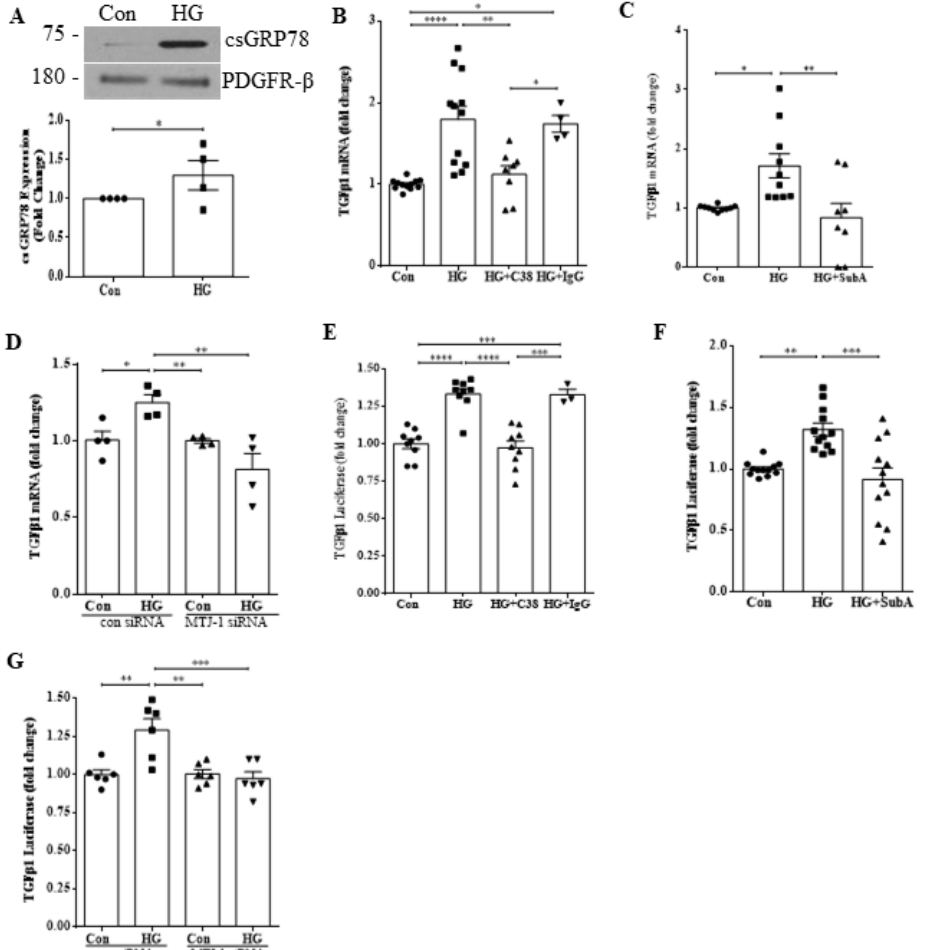
Figure 1. csGRP78 mediates TGF β 1 transcription in response to HG. ( A ) HG (6 h) induced cell surface localization of GRP78 in MCs ( n = 4, * p < 0.05). ( B ) The GRP78 antibody C38 attenuated HG (48 h)-induced TGF β 1 transcript upregulation compared to nonspecific IgG (2 µg for each antibody, n = 12, * p < 0.05, ** p < 0.01, *** p < 0.005). ( C ) Cleavage of the C-terminus of csGRP78 with SubA (25 ng/mL) prevented TGF β 1 transcript upregulation by HG (48 h) ( n = 10, * p < 0.05, ** p < 0.01). ( D ) (48 h)-induced TGF β 1 mRNA upregulation compared to control siRNA (100 nM, n = 4, * p < 0.05 **